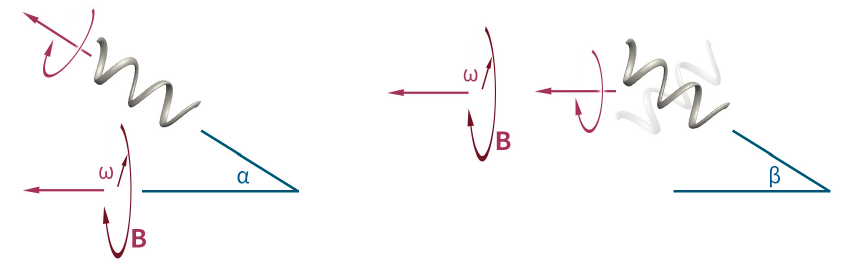
Figure A1. Calculation of the steadiness variable. The left image describes the shifting phenomenon and the right image the wobbling phenomenon.